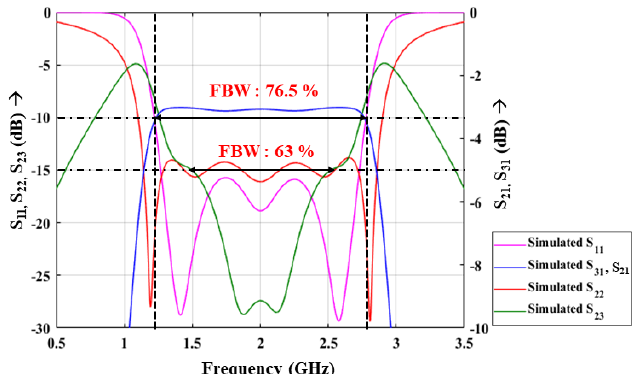
Figure 21. Simulated S − parameters (dB) for θ c = 65 ◦ .